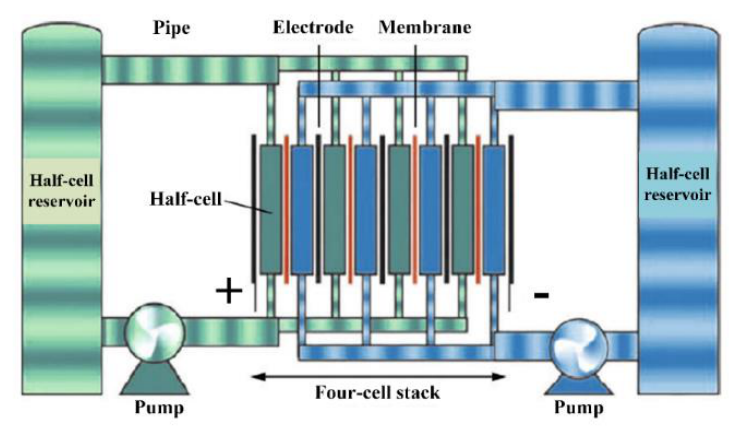
Figure 47. Schematic diagram of flow battery. The electroactive species dissolved in the electrolyte flows through the power core, converting the chemical energy to electricity [6].